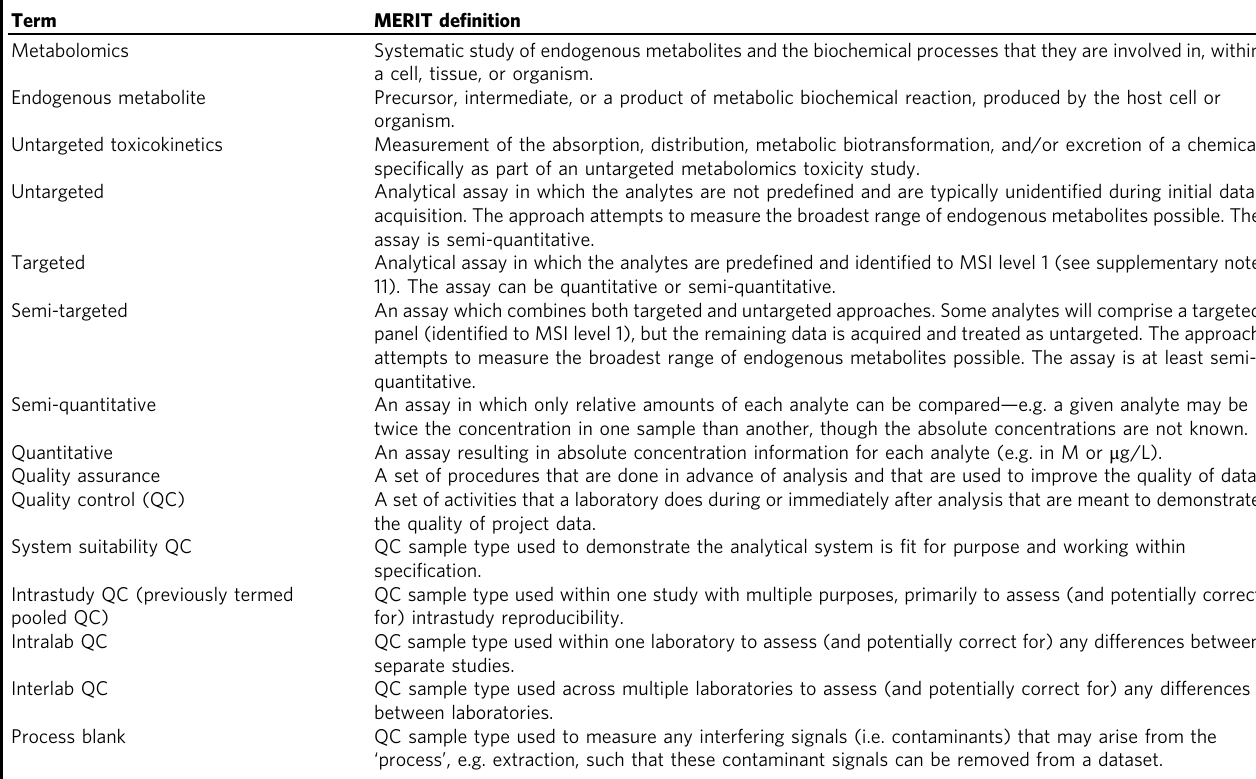
Table 1 De fi nitions of key terms used in the best practice guidelines and reporting standards Term MERIT de fi nition